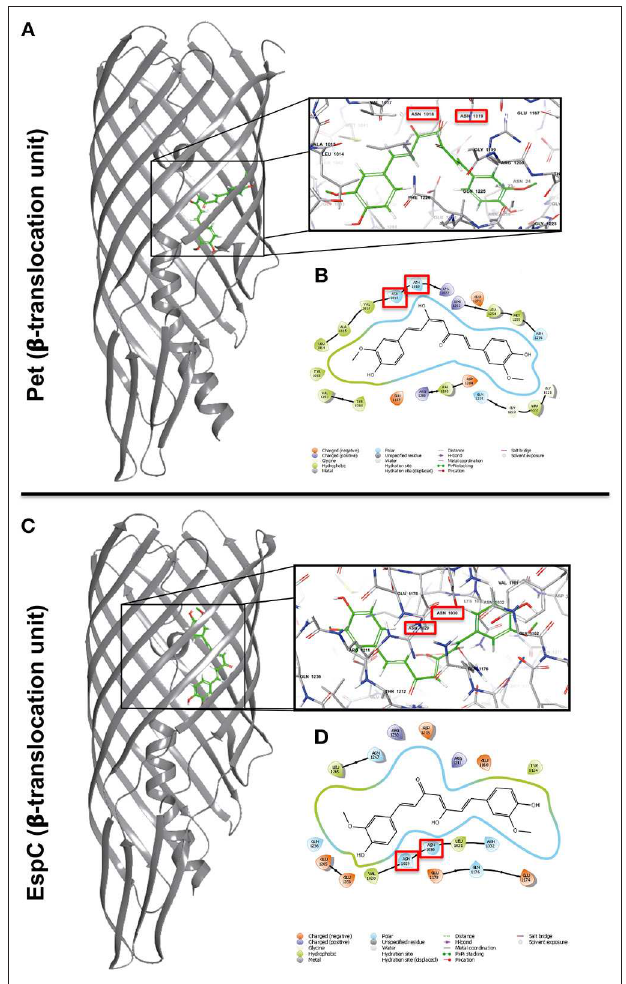
FIGURE 7 | Representation of the Pet and EspC β -barrel translocation units and the predicted binding modes of curcumin to the protein. Predicted binding modes of curcumin at the Pet (A) and EspC (C) β -barrel translocation units. Most probable binding mode calculated for curcumin as predicted by AutoDock at the Pet and EspC β -domains, respectively (B,D) . Red rectangle highlights the interaction of important asparagine residues required for the release of Pet and EspC β